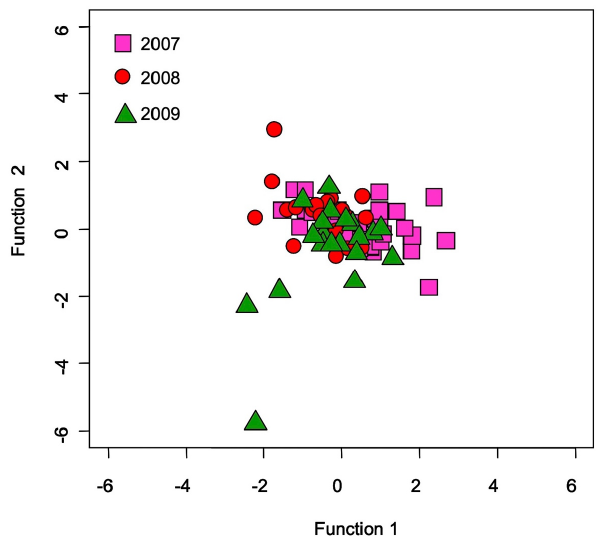
Figure 2. Quadratic discriminant function analysis over three years (2007, 2008, 2009) based on all the otolith elemental ratios (Na:Ca, Mg:Ca, P:Ca, K:Ca, Sr:Ca, and Ba:Ca) in the Japanese eel ( An- guilla japonica ) collected in Oi River, Shizuoka Prefecture,